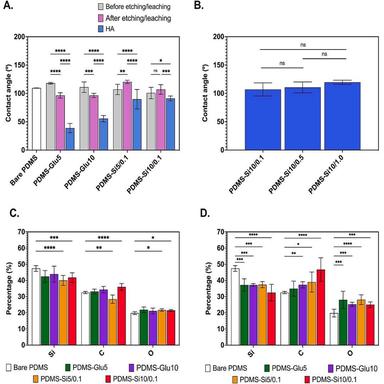
A. Wettability of bare PDMS vs. PDMS-modified MNs. Error bars represent SD. \ Significant differences between different treatment conditions in the same sample (n = 10). 0.1234 (ns); 0.0332 (\), 0.0021 (\\), 0.0002 (\\\), <0.0001 (\\\\). B. Wettability of PDMS-Si10 MNs with different NaOH concentrations. Error bars represent SD. ns - non-significant differences between different treatment conditions in the same sample (n = 10). C. EDS analysis of elemental silica (Si), Carbon (C) and Oxygen (O) on MNs after